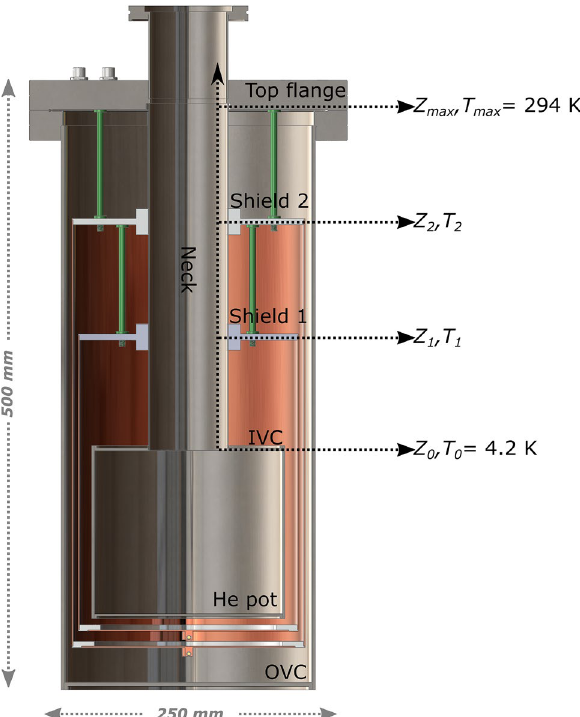
Figure 3. Reference sketch for the numerical model of the cryostat. From top to bottom we find the top flange placed at height Z max and room temperature (294 K); the shield 2 placed at height Z 2 and temperature T 2 ; the shield 1 placed at height Z 1 < Z 2 and T 1 < T 2 ; the He pot whose top part is placed at Z 0 and its temperature is considered fixed at T 0 = 4.2 K, despite the liquid He level. The top flange together with the neck and the He pot form the IVC (inner vacuum chamber). The dotted horizontal black arrows indicate position and temperature of the elements listed above. The dotted vertical black arrow indicates the direction for increasing value of the z-coordinate . The OVC (outer vacuum chamber) closes the cryostat and the vacuum in between IVC and